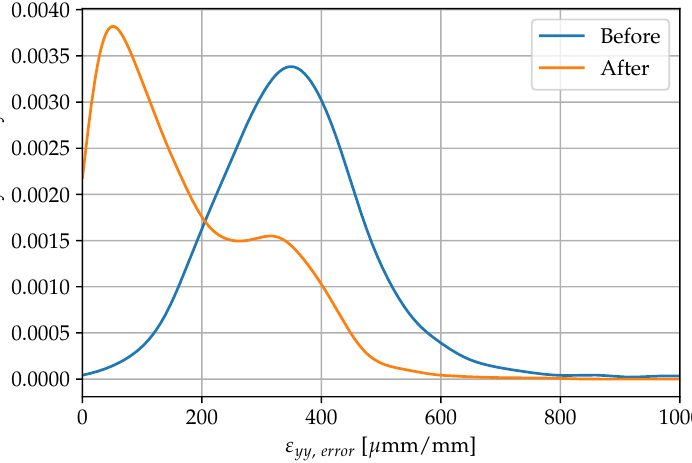
Figure 13. A histogram showing the change in the probability density of the error from the application of the error compensation method. This data is also for the 700th image of Test